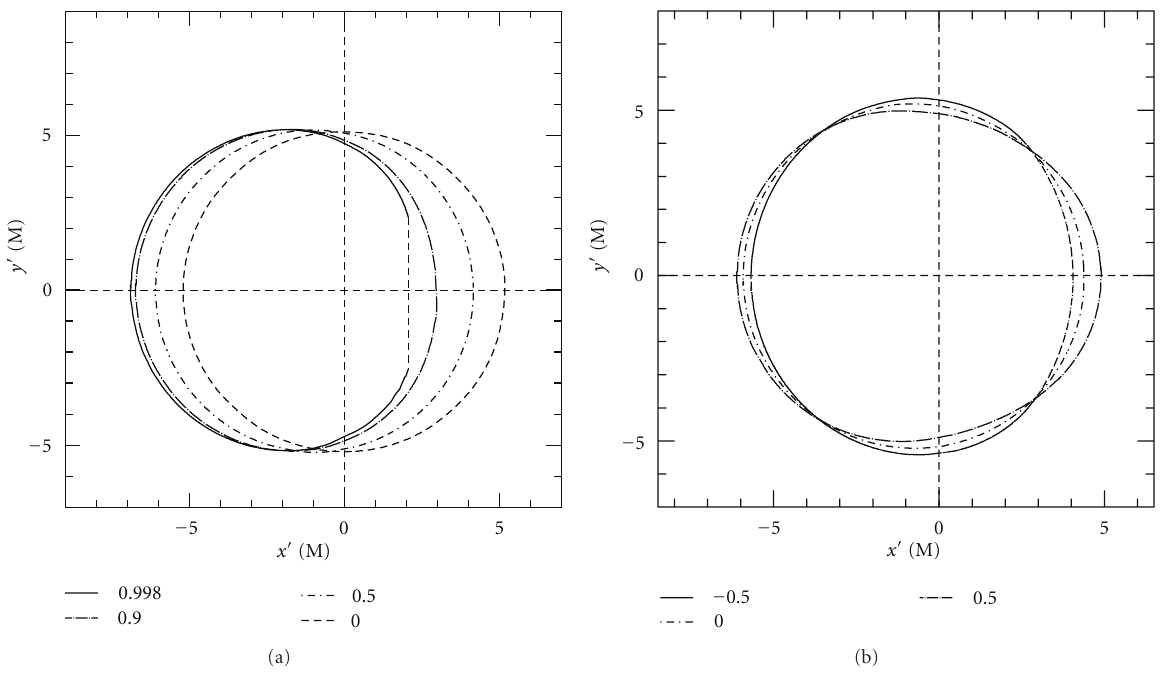
Figure 4: Images of rings of light of (a) a Kerr and (b) a quasi-Kerr black hole at an inclination cos i = 0 . 25. Increasing values of the spin cause a displacement of the ring in the image plane, but the ring remains (nearly) circular for values of the spin a (cid:2) 0 . 9 M (a). Nonzero values of the deviation parameter (cid:2) (b) lead to an asymmetric ring image